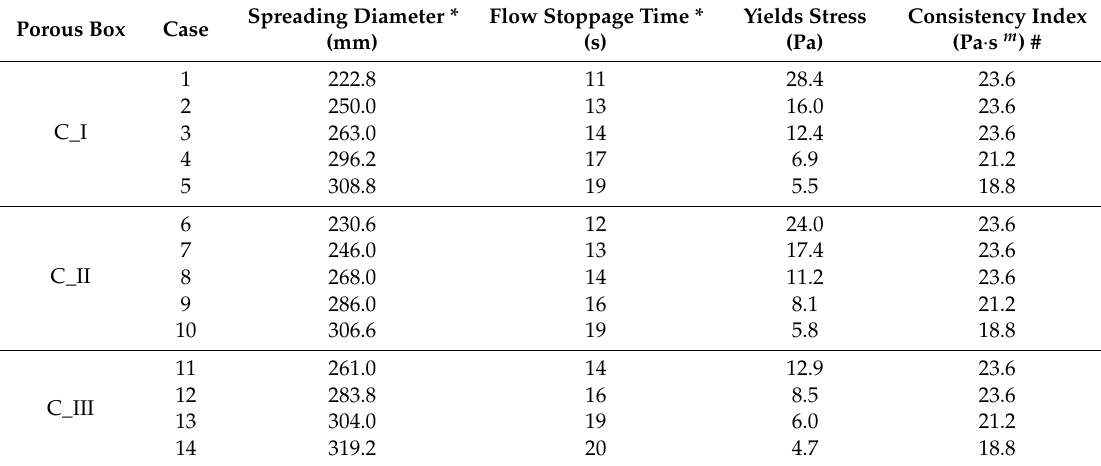
Table 2. The numerical simulation cases and the rheology parameters of SCM.